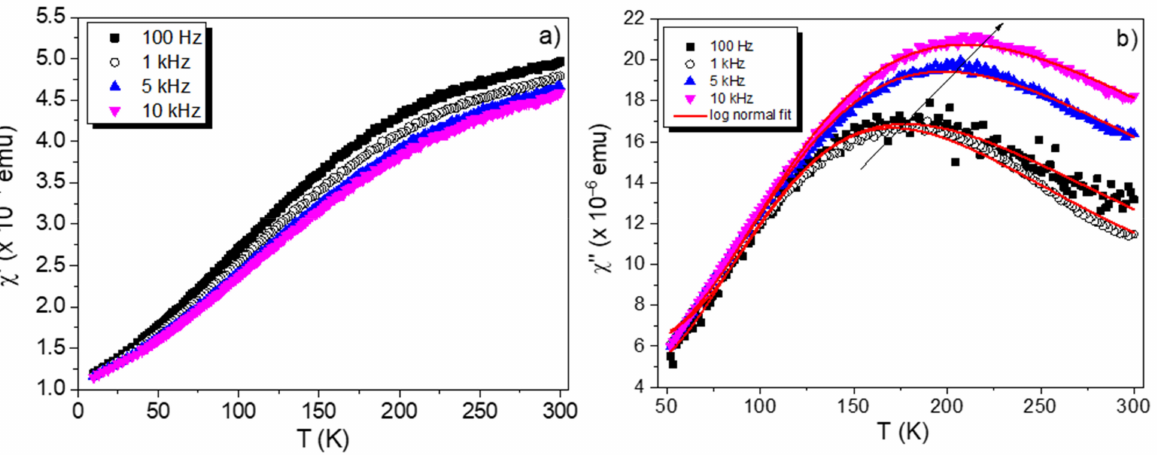
Figure 2. In-phase χ (cid:48) ( a ) and out-of-phase χ ” ( b ) components of the AC magnetic χ for zero DC external magnetic